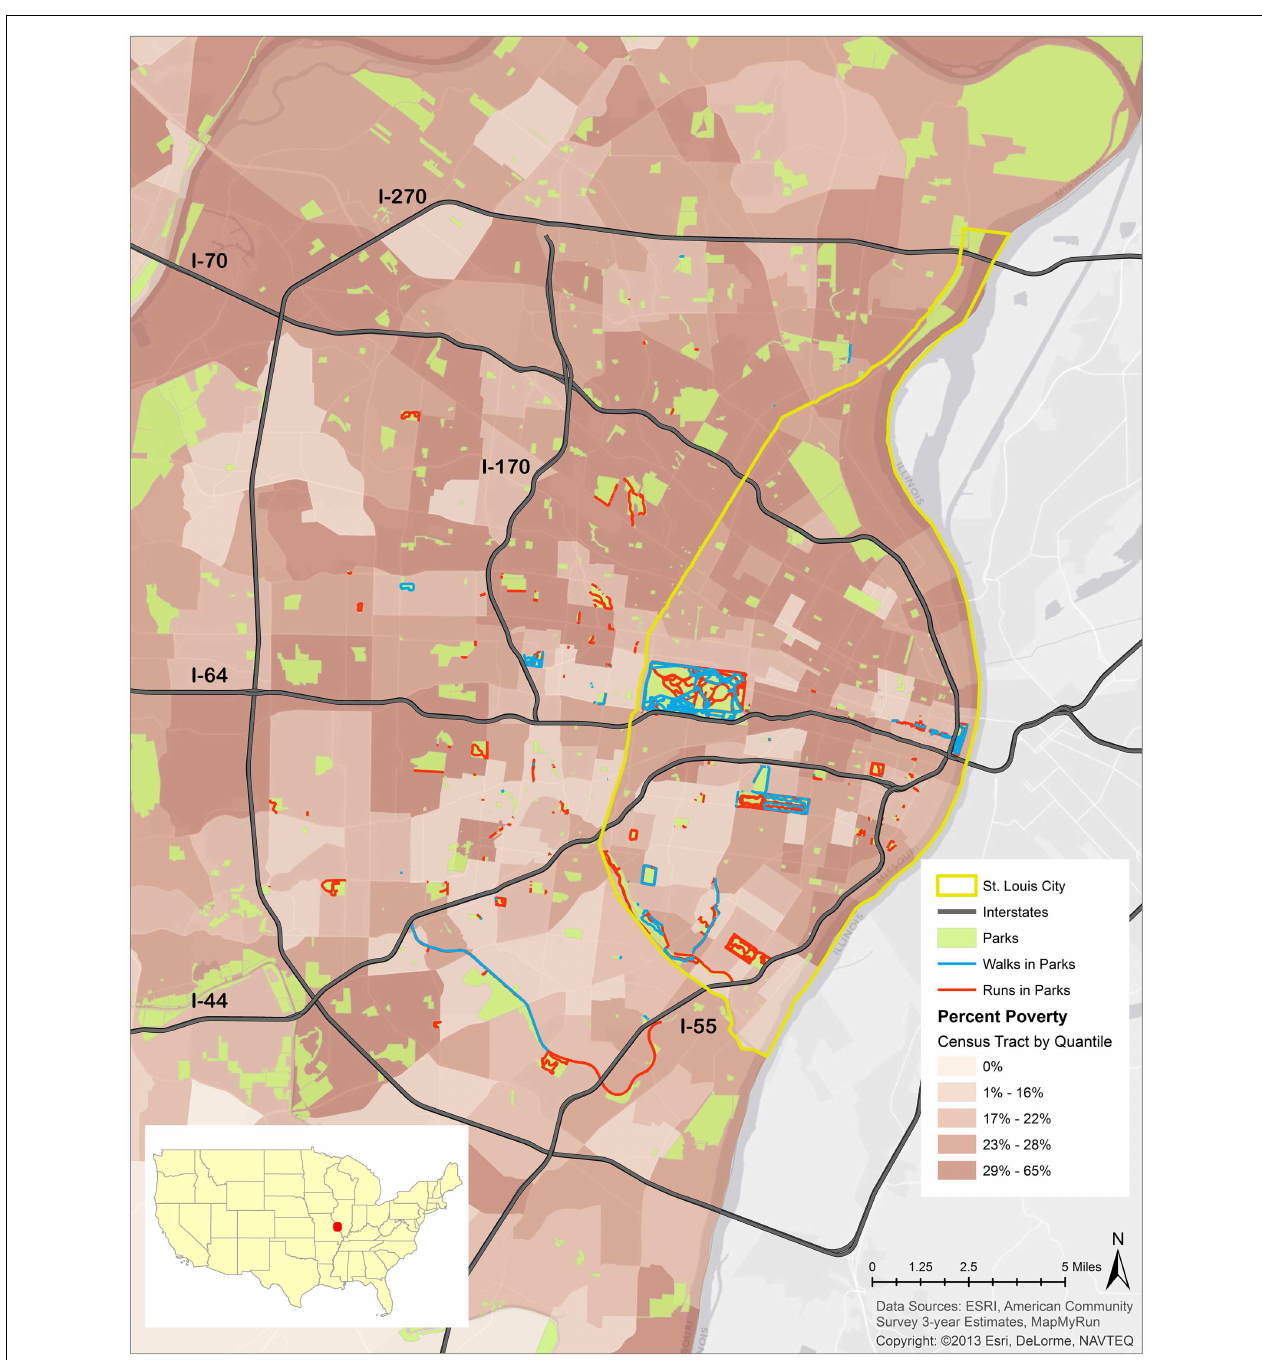
FIGURE 2 | Running and walking routes in parks and poverty rate in St. Louis, MO, USA